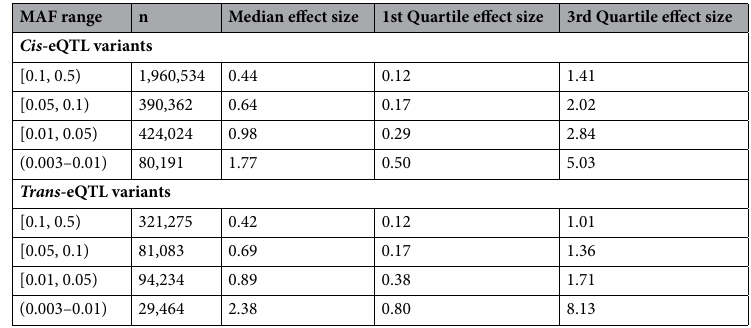
Table 2. Comparison of effect sizes of eQTLs with different minor allele frequency ranges. MAF minor allele frequency, n the number of eQTLs, effect size the effect size of association between eQTL and eGene.